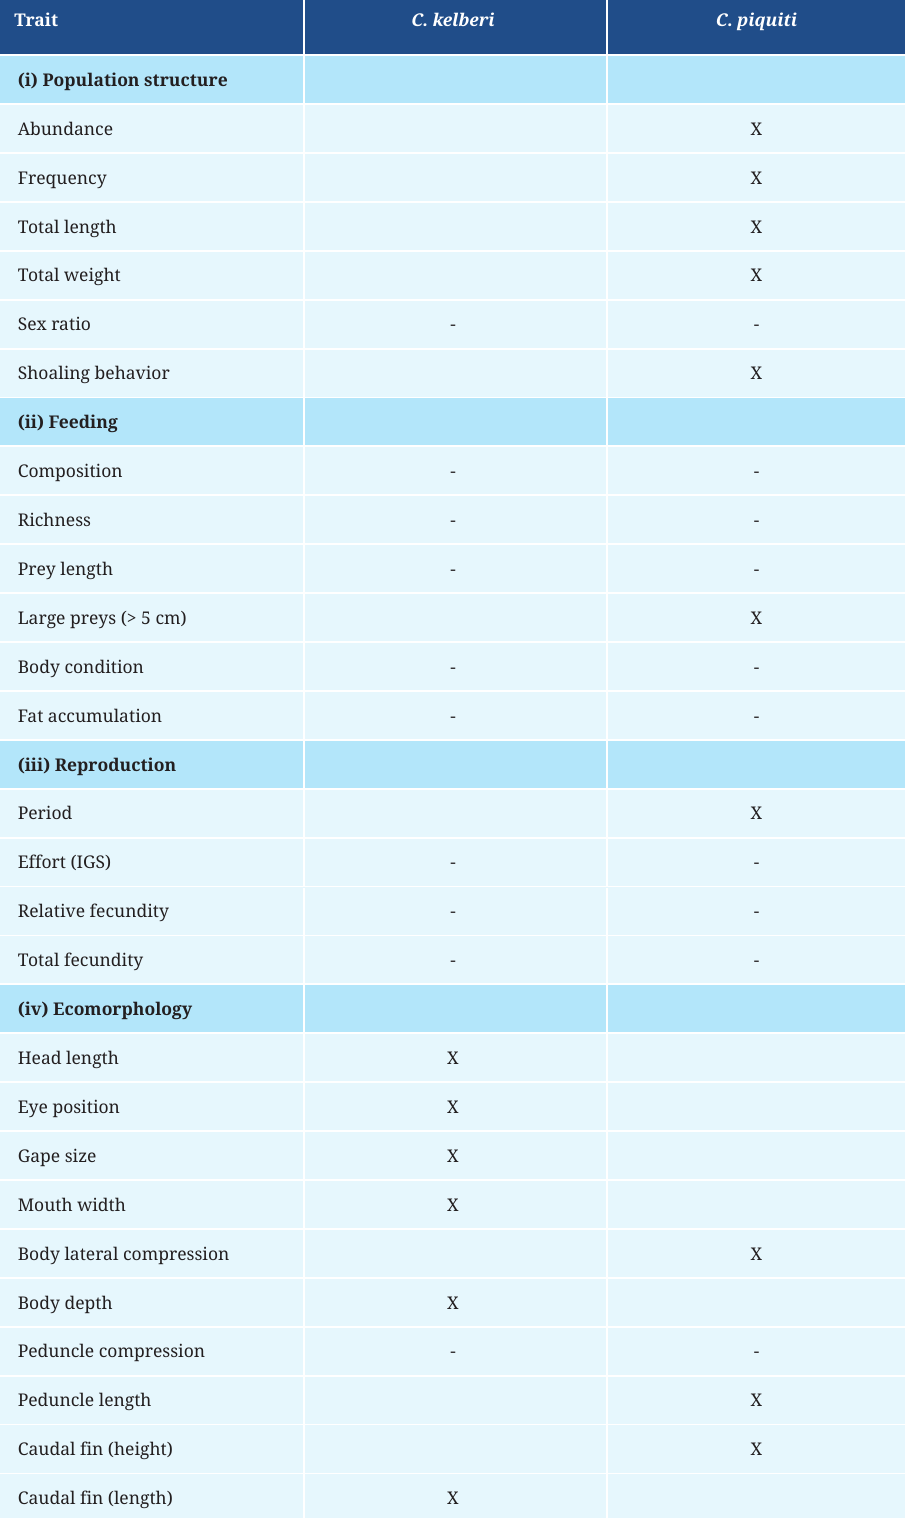
TABLE 3 | Synthesis of population and functional traits analyzed in this study, with indication of differences between species. X = higher values. - = no clear statistical Trait